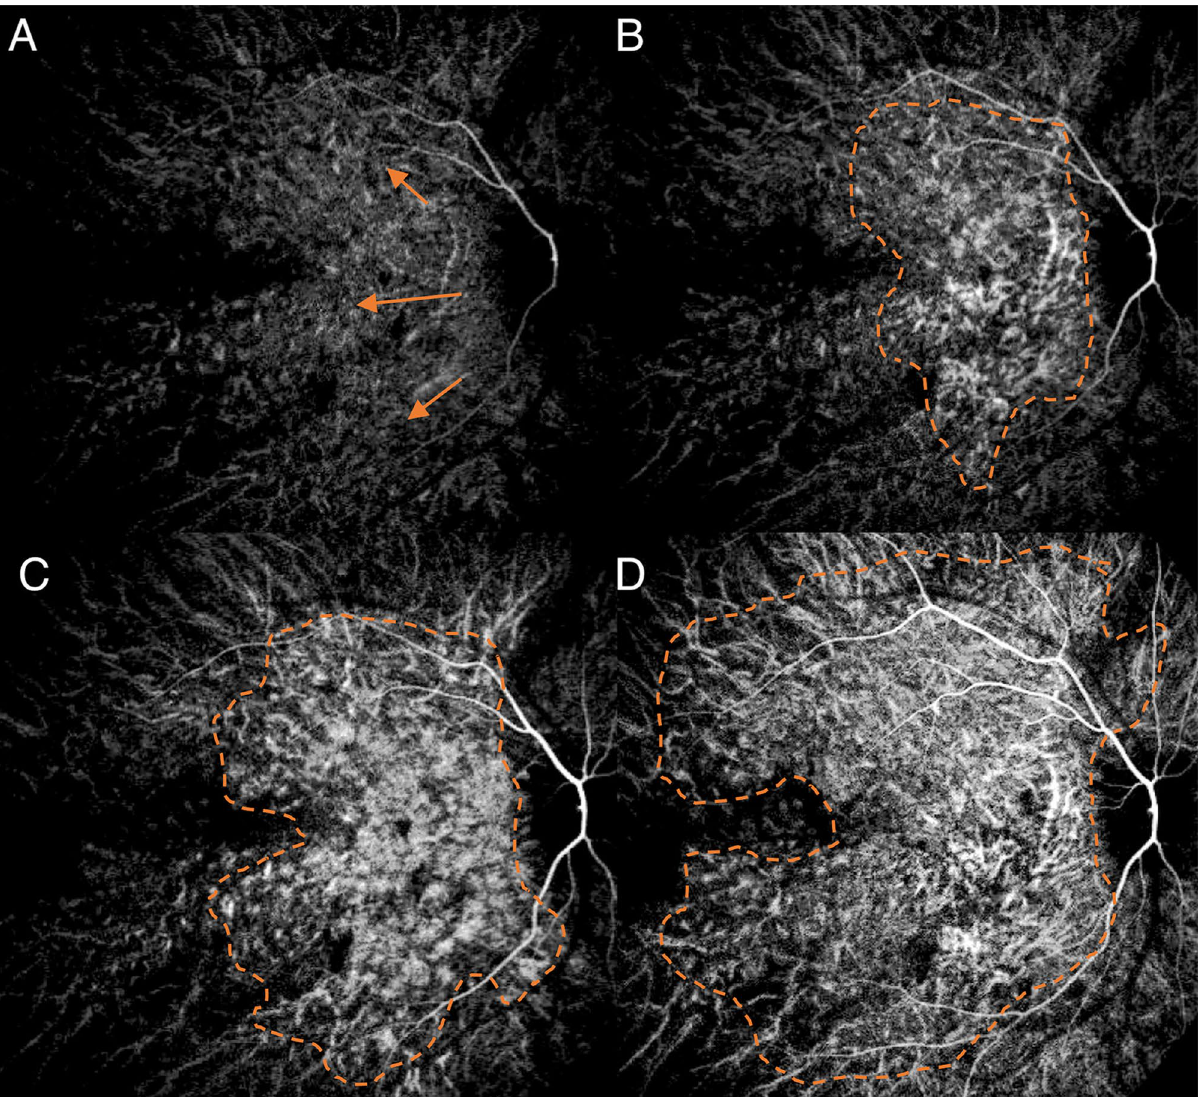
Figure 3. Digital subtraction indocyanine green angiography of the second monkey. ( A ) Dye first entered the peripapillary area of choriocapillaris in regions around the optic disc and posterior pole. (orange arrows). ( B ) Units appear bright around the optic disc. ( C ) Dye filling progressed radially to the macular region. Many units of variable size and shapes were discernible, separated from each other by dark zones. ( D ) Dye filling in the posterior pole region appeared fairly